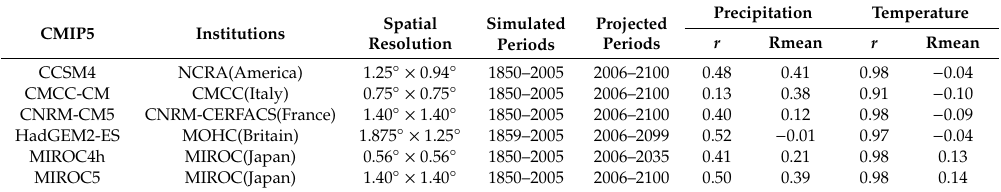
Table 1. Basic information of Coupled Model Intercomparison Project phase 5 (CMIP5) models and their accuracy evaluation between 1960 and